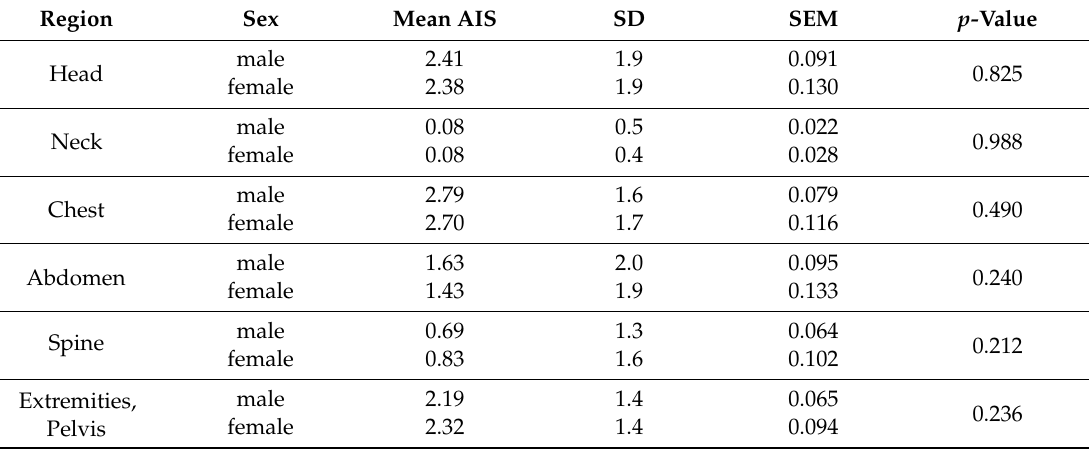
Table 1. Injury Severity Scores.